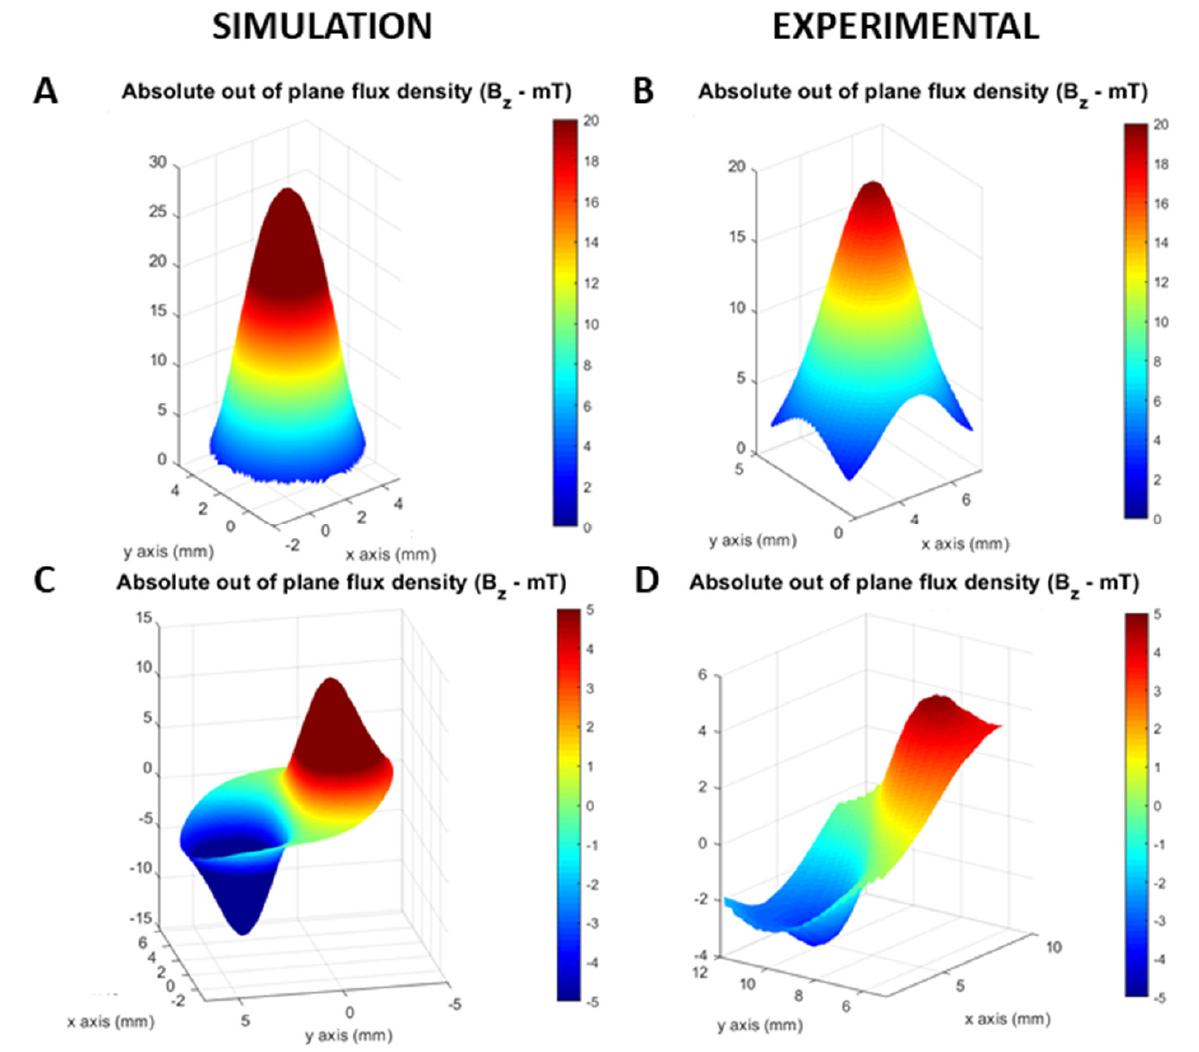
Figure 4. Magnetic polymer composite characterization: ( A ) measurement of the part magnetized using the axial magnet; ( B ) simulation of the part magnetized using the axial magnet; ( C ) measurement of the part magnetized using the diametric magnet; ( D ) simulation of the part magnetized using the diametric magnet.